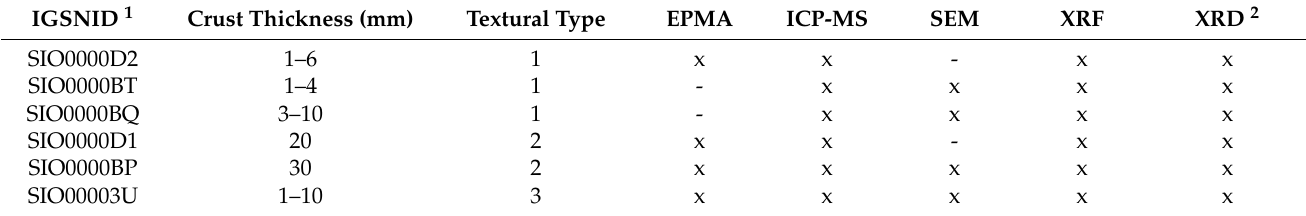
Table 1. Description of samples and list of performed analyses.